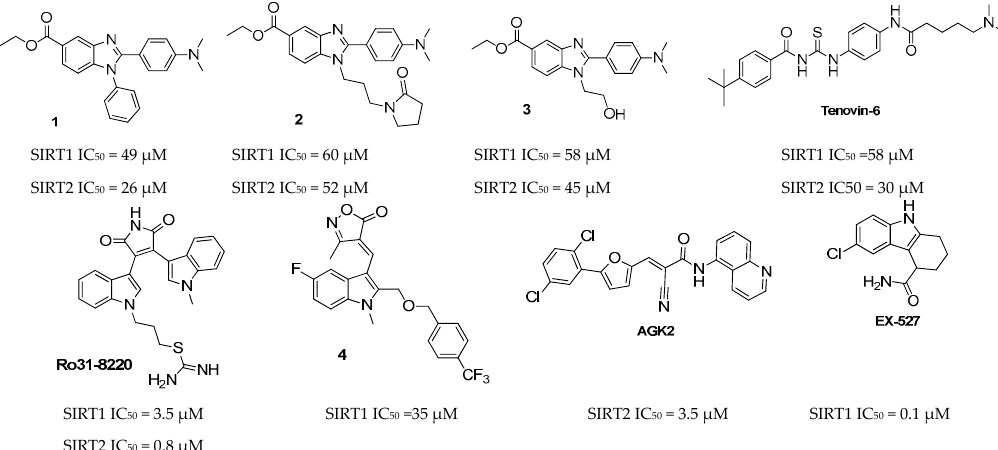
Figure 1. The chemical structures of some known sirtuin inhibitors.